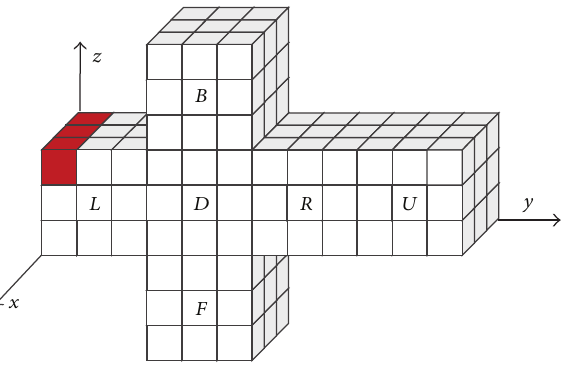
Figure 6: A split cube with 3 unfolded scramble cubes.